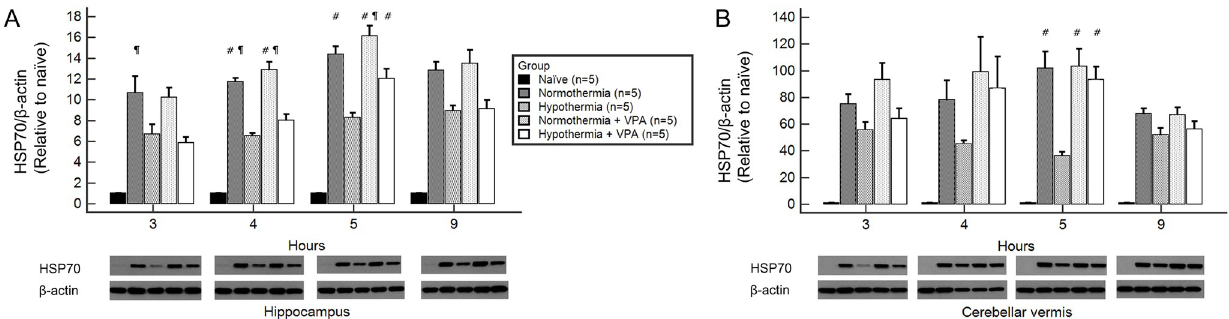
Fig 4. HSP70 mRNA of regional brain homogenates obtained at 3, 4, 5, and 9 hours after ROSC by RT-qPCR analysis. At four hours after ROSC, normothermic groups (normothermia, normothermia + VPA) showed significantly higher HSP70 mRNA level than the hypothermia group regardless of regions. The hypothermia + VPA group showed significantly higher HSP70 mRNA level in the cerebellar vermis than the hypothermia group at 4 hours after ROSC (B). In the hippocampus, the hypothermia + VPA group also showed higher HSP70 mRNA level than the hypothermia group at 4 hours after ROSC, although such difference was not statistically significant (A). Bars represent mean ± SEM. Intergroup comparison was performed by one-way analysis of variances with Scheffe´ post-hoc analysis. # , p < 0.05 versus hypothermia; ¶ , p < 0.05 versus hypothermia + VPA.